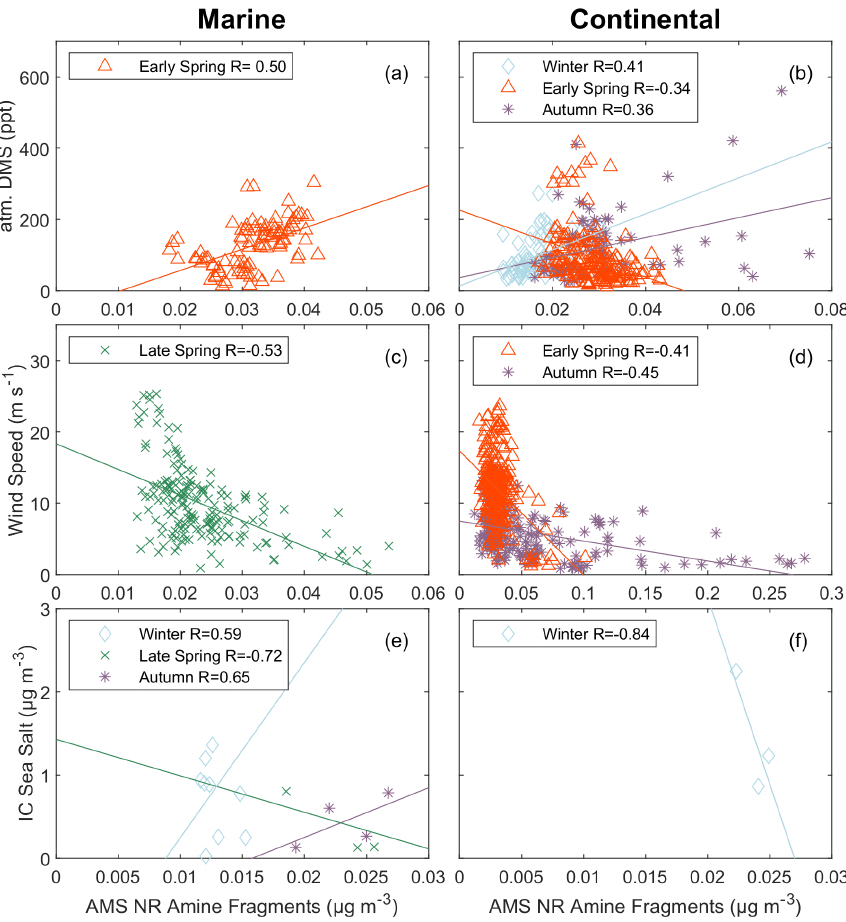
Figure 4. Scatterplot of marine tracers versus AMS NR amine fragments for marine periods (a, c, e) and continental periods (b, d, f) . The panels include atmospheric DMS (a, b) , wind speed (c, d) , and IC sea salt (e, f) . Markers represent each cruise: blue open diamond – winter, green cross – late spring, purple asterisk – autumn, and red open triangle – early spring. The solid lines are the lines of best fit obtained using an ordinary least squares regression for R | ≥ 0 .